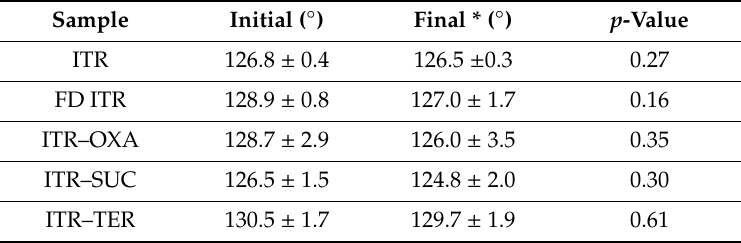
Table 2. Contact angle of a water droplet at the start and end of the measurement as well as the statistical analysis indicating no difference between the initial and final values.